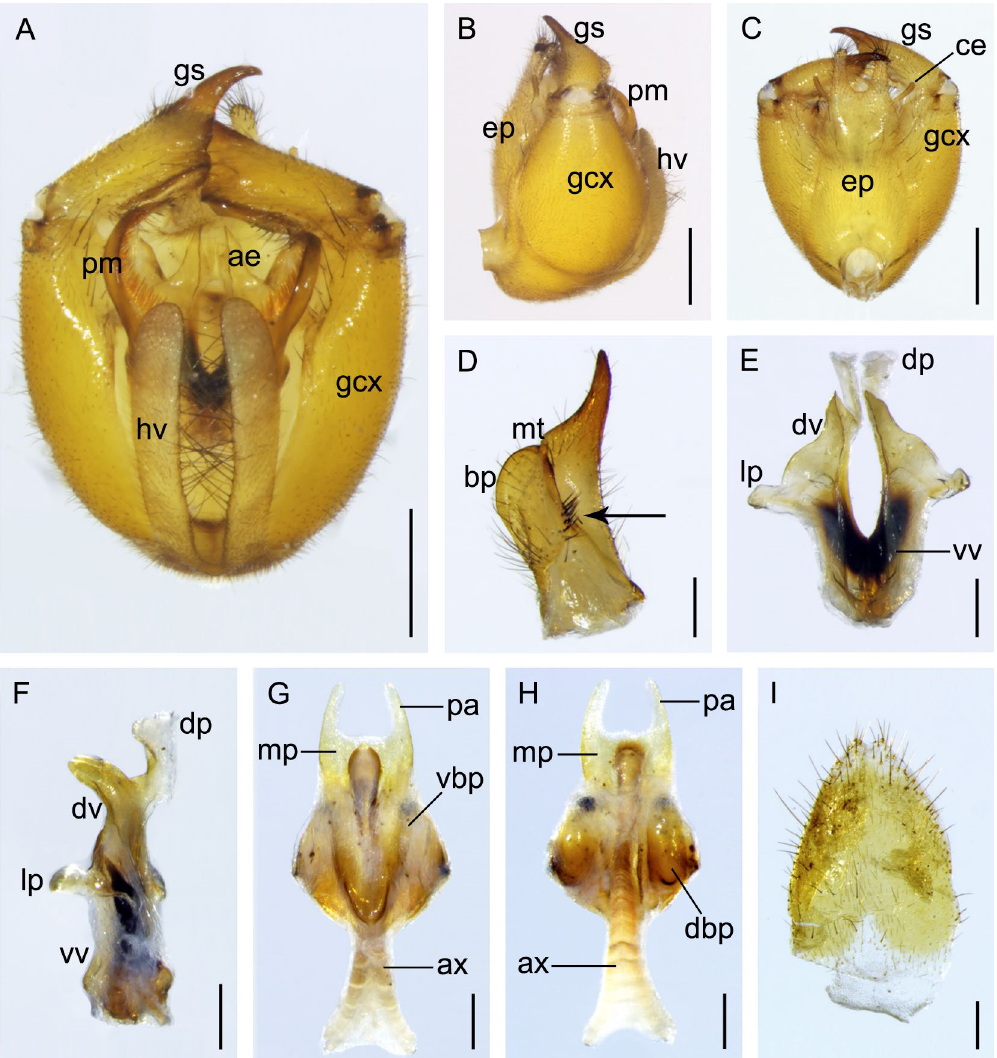
Fig. 8. Genitalia of Cerapanorpa taizishana sp. nov. A–C . Male genital bulb in ventral, lateral and dorsal views. D . Gonostylus in lateral views, arrow indicates the stout setae. E–F . Aedeagus in ventral and lateral views. G–H . Female medigynium in ventral view and dorsal views. I . Subgenital plate in ventral view. Abbreviations: ae = aedeagus; ax = axis; bp = basal process; ce = cercus; dbp = dorsal basal plate; dp = dorsal process; dv = dorsal valve; ep = epandrium; gcx = gonocoxite; gs = gonostylus; hv = hypovalve; lp = lateral process; mp = main plate; mt = median tooth; pa = posterior arm; pm = paramere; vbp = ventral basal plate; vv = ventral valve. Scale bars: A–C = 0.5 mm; D–I = 0.2